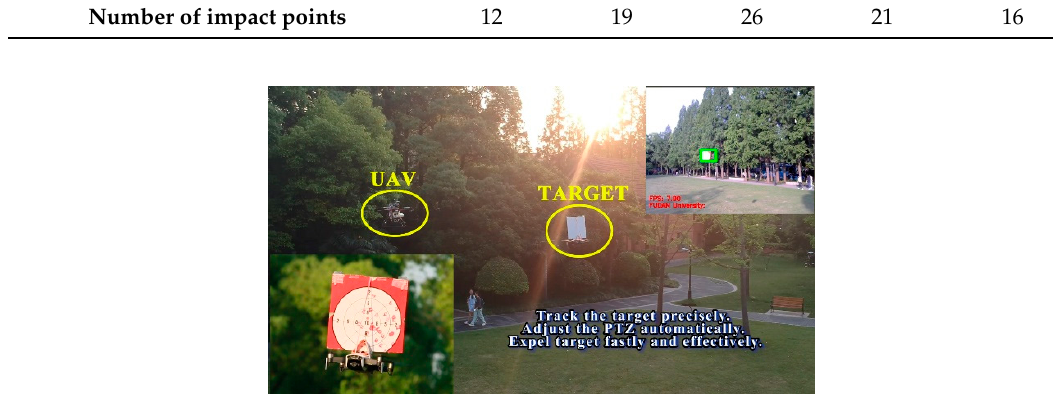
Figure 26. Outdoor dynamic expelling test.